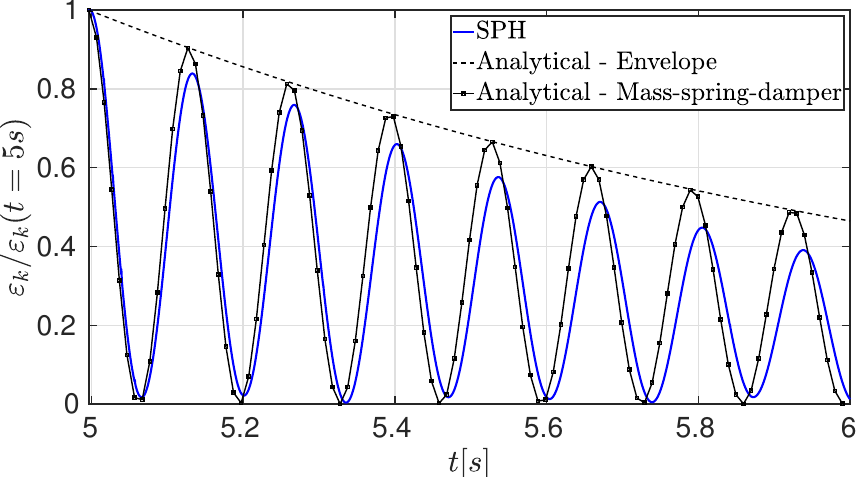
Figure 13. Comparison of the evolution of the relative liquid kinetic energy and the analytical periodic approximation and its